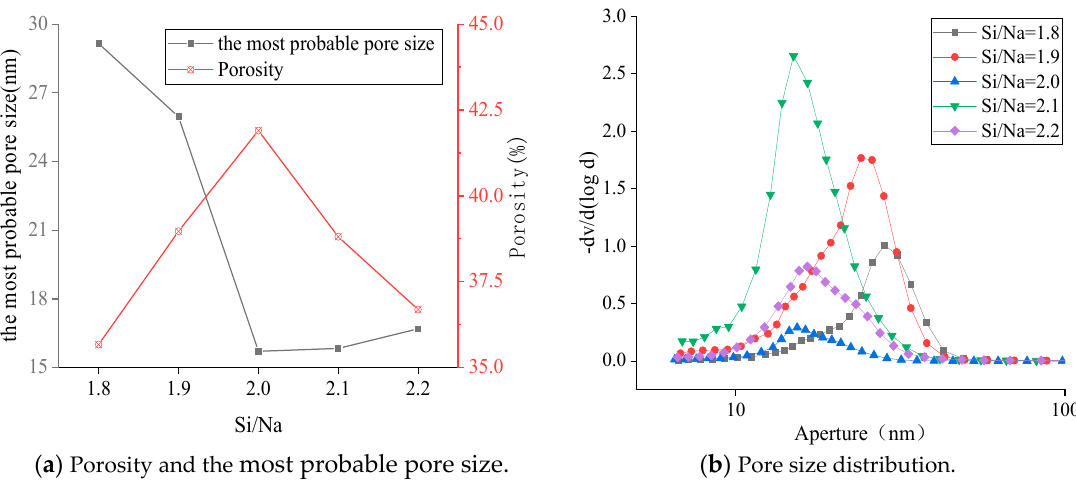
Figure 11. Changes in the pore structure parameters of the geopolymer samples with different Si/Na ratios.